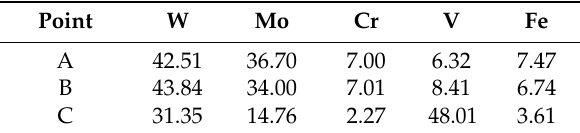
Figure 5. Microstructure of the composite layer at low ( a ) and high ( b ) magnification. Table 2. Chemical composition of the carbides (wt. %).